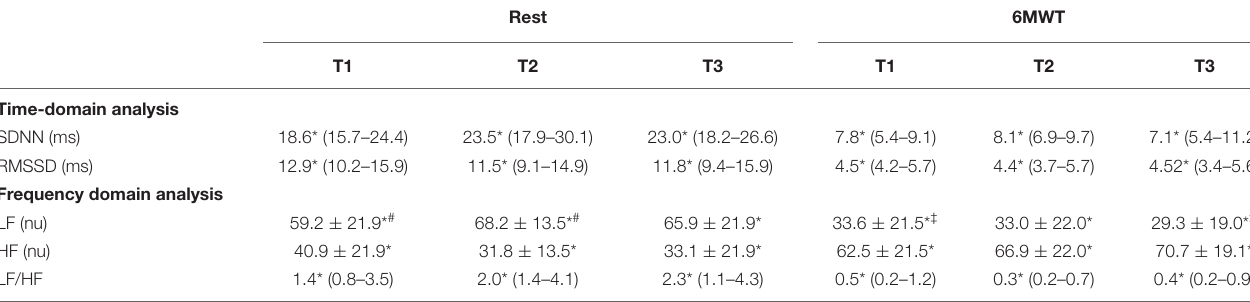
FIGURE 1 | Dot plot of individual distances, mean heart rates, dyspnea levels during the 6MWT, and MFI20 scores throughout the PR program. (A) 6MWT distance (m); (B) mean heart rate (beats.min − 1 ); (C) dyspnea level; (D) MFI-20 score; ( n = 23 for A–D ). Mean and standard deviation are represented by a dot and a line both in gray. Repeated ANOVA revealed a significant difference for the 6MWT distance, mean heart rate and perceived fatigue throughout the PR program [ F (2,44) = 38.2, p < 0.05, η 2 = 0.11; F (2,44) = 5.11, p < 0.05, η 2 = 0.2; and F (2,44) = 23.74, p < 0.001, η 2 = 0.21, respectively]. Post hoc analyses revealed that 6MWT distances at T3 and T2 were significantly higher compared to T1 ( p < 0.001), mean heart rate during the 6MWT at T3 was significantly higher compared to T1 ( p < 0.001) and MFI-20 scores at T3 (45.04 ± 10.5) and T2 (45.9 ± 11.7) were significantly lower compared to T1 (58.3 ± 13.6, p < 0.001). TABLE 2 | Effect of pulmonary rehabilitation on the analyses of R-R interval series in temporal and frequency domains at rest and during the 6MWT. Rest